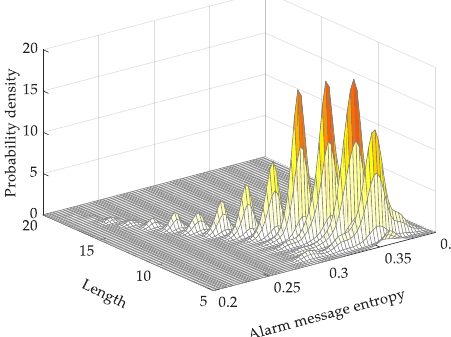
Figure 7. Probability density map of average TF-IDF alarm-message entropy.